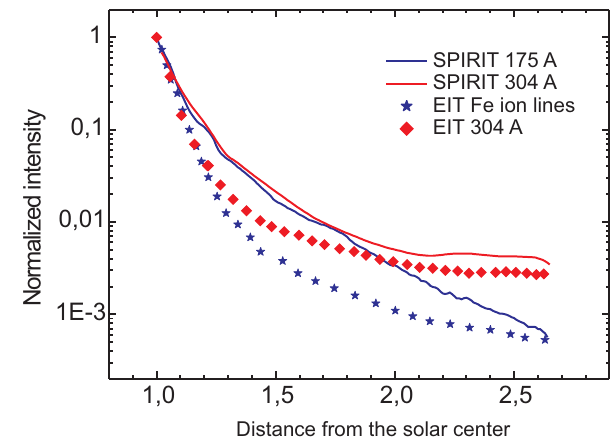
Fig. 9. Normalized radial distributions of the EUV coronal bright- ness with the distance at the equatorial plane: solid blue and red lines – the SPIRIT data for the west equatorial line taken on 16 June 2002 in the 175 and 304 ˚A bands correspondingly, red diamonds and blue stars – the EIT data for the east equatorial line taken on 4 April 1996 in the 304 ˚A band and the averaged data obtained in the EIT 171, 195 and 284 ˚A bands.